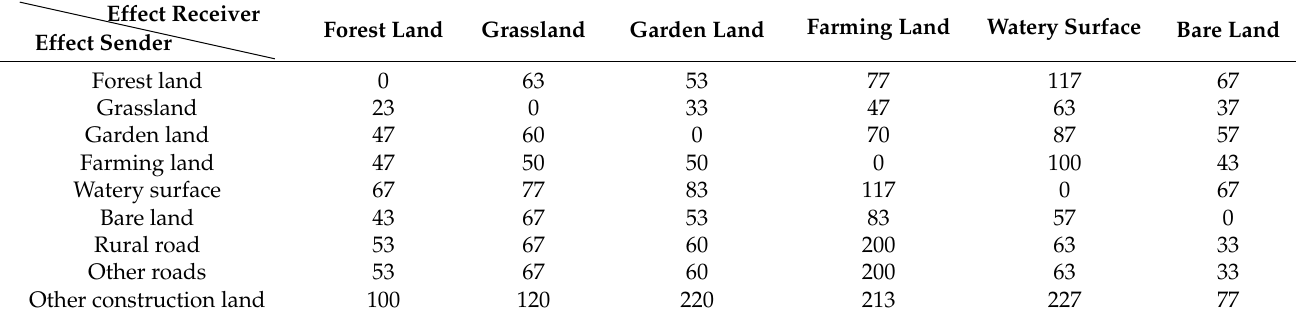
Table 2. Influencing distances of the neighboring effect (Unit: m).